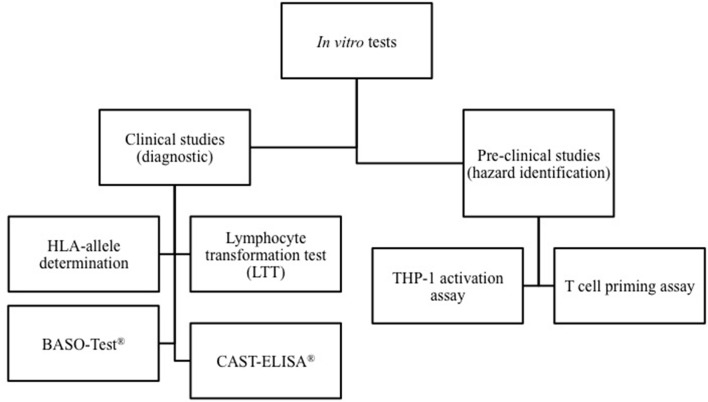
Classification of in vitro models able to assess drug-inducing hypersensitivity reactions. In vitro diagnostic tests can be divided in test able to identify the culprit drugs at the resolution of the reaction, and methods that allow to determining the individual risk of HDR before drug administration. On the other hand, some in vitro methods may be used in the pre-clinical phase of drug development for hazard identification of potential to induce hypersensitivity reactions.